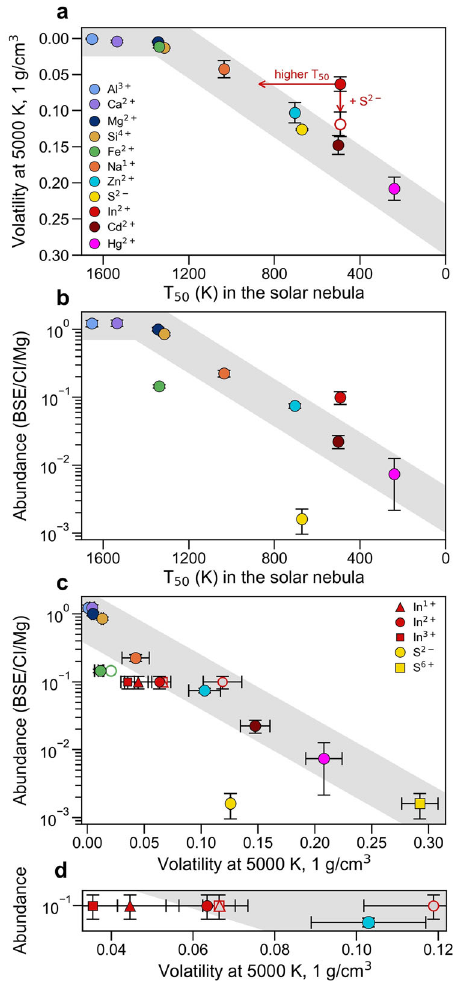
Fig. 3 Volatile element depletion trends. a The volatility of elements from pyrolite melt calculated from the ab initio molecular dynamics results of this study at 5000 K and 1 g cm − 3 against the 50% condensation temperatures in the solar nebula gas 4 , demonstrating the linear relationship between the volatility of the elements from pyrolite and the 50% condensation temperatures in the solar nebula gas. Here, volatility is de fi ned as the proportion of the volatile elements existing in the vapor phase in equilibrium with pyrolite melt. b The abundance of the elements in the bulk silicate Earth (BSE) relative to CI chondrites, normalized to the abundance of Mg 19 , as a function of the 50% condensation temperatures in the solar nebula gas 4 . c The abundance of the elements in the BSE as a function of their volatility as calculated from the ab initio molecular dynamics simulations of this study at 5000K and 1 g cm − 3 . The volatilities of In 1 + (triangle), In 2 + (circle), and In 3 + (square) are shown in the absence of S 2 − (solid red symbols) and in the presence of S 2 − (open red symbols). d Magni fi cation of the region with In 1 + , In 2 + , In 3 + , and Zn 2 + of part ( c ). Gray bands are guides for the eyes. Uncertainties on computed volatilities correspond to the convergence window of the volatilities with simulation